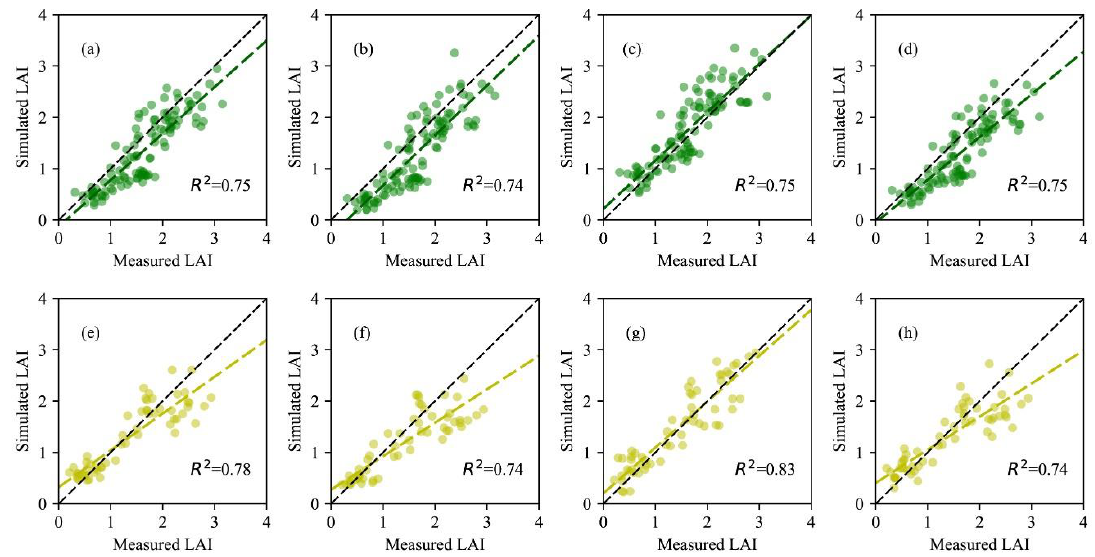
simulated LAI. RMSE = root-mean-square error, MRE = mean relative error.